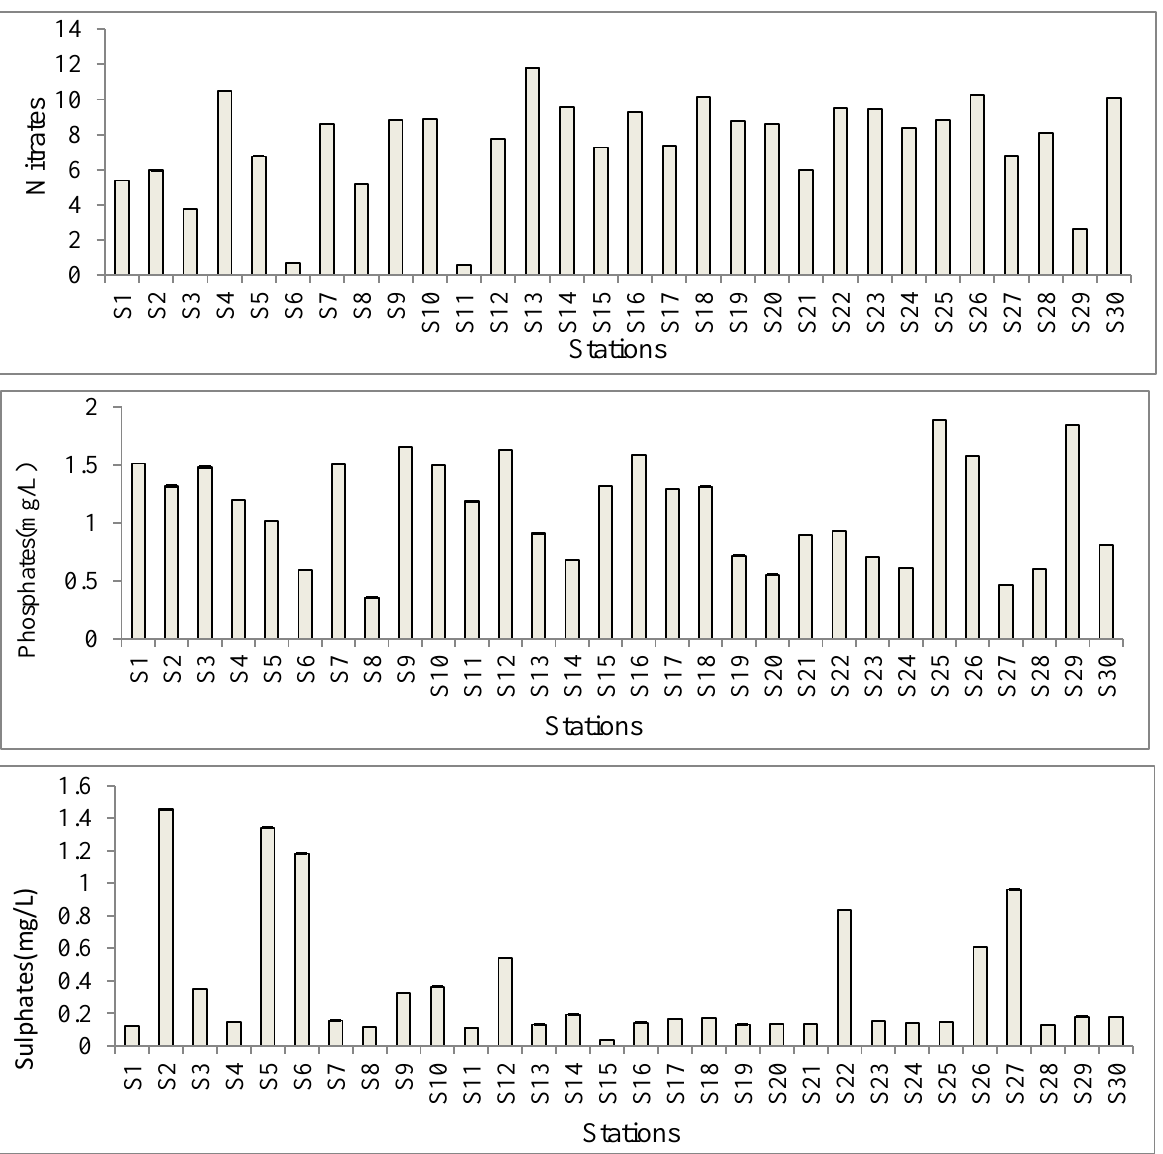
Figure 5. Physico-chemical variables at different stations/ponds.